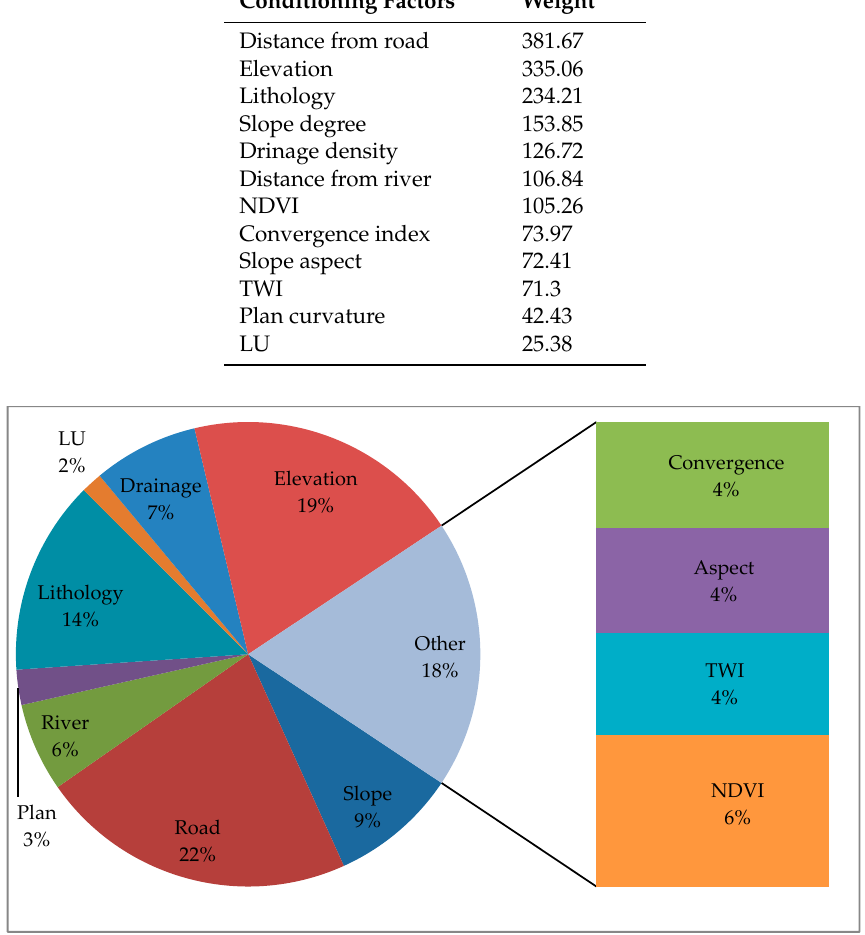
Table 5. Relative influence of effective conditioning factors in the RF model.